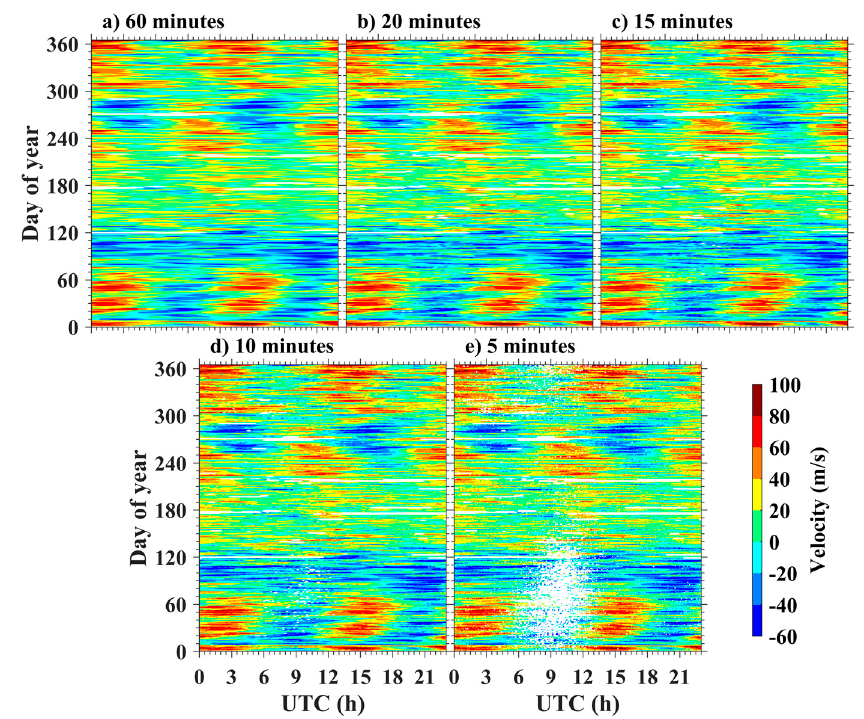
Figure 4. Hour − day cross sections of zonal winds retrieved under different temporal resolutions in 2013. The blank spaces are due to a lack of meteor counts.